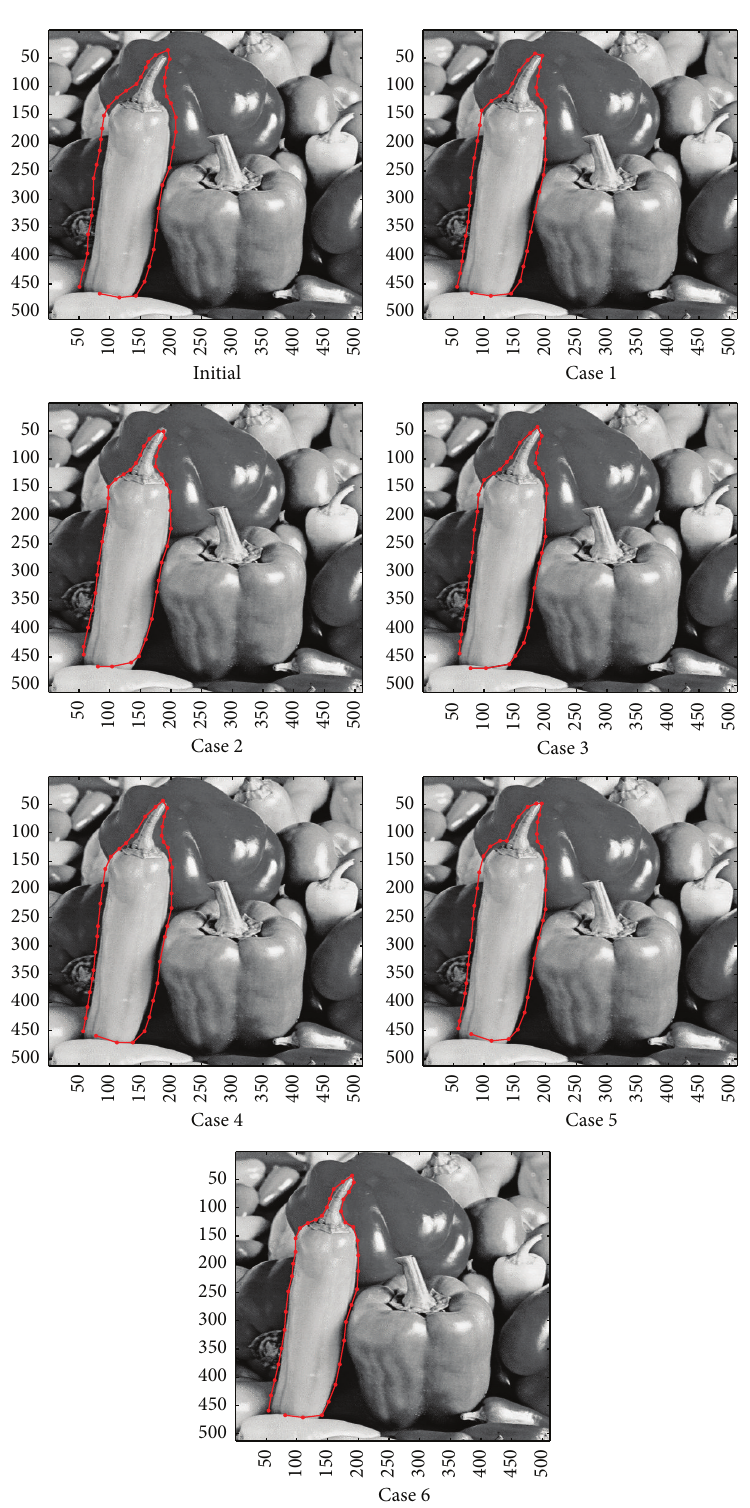
Figure 18: Active contour model implementation by “proposed multiswarm PSO” method for different cases of inertia. Results for “Peppers” image with control points = 40, 𝛼 = 0.25 , 𝛽 = 0.22 , and Γ = 0.50